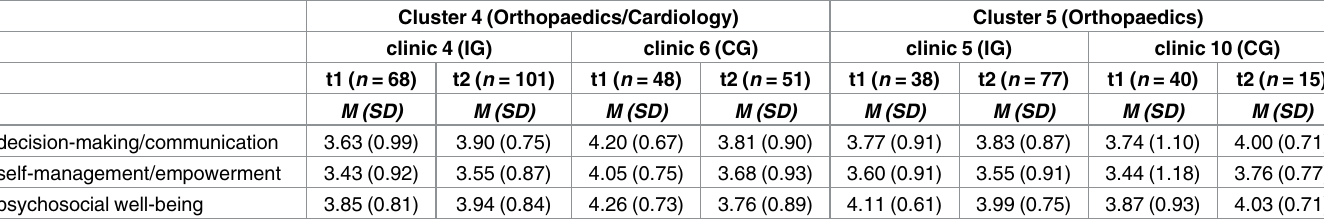
Table 9. Clinic specific means of outcome criteria of the patient survey (Cluster 4 and 5).